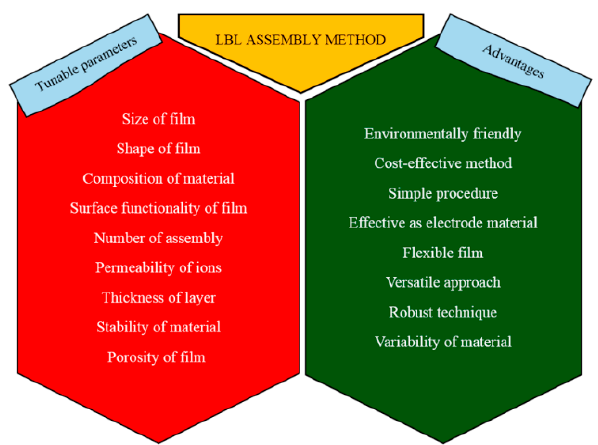
Figure 1. Scheme of the most relevant features of the LbL method for the assembly of nanostructures materials. Reprinted from Kulandaivalu et al. [42], with permission under Open access CC BY 4.0 license, https://creativecommons.org/licenses/by/4.0/ (accessed on 9 April 2022).